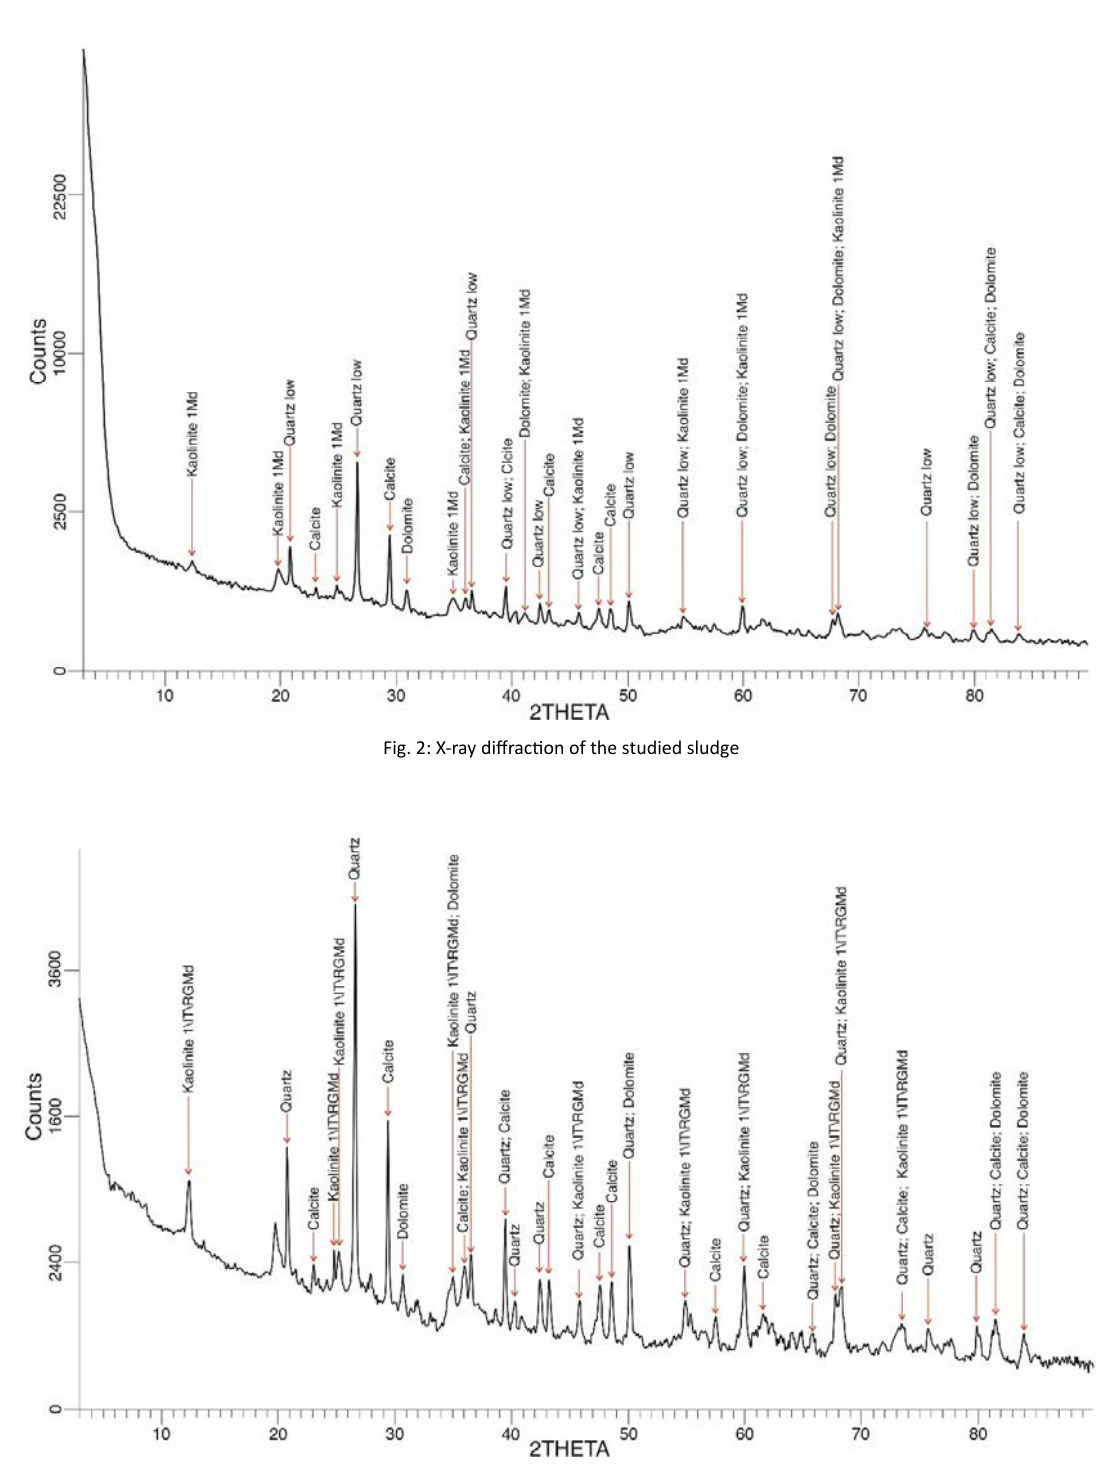
Fig. 3: X-ray diffraction of natural Fig. 3: X‐ray diffraction of natural clay